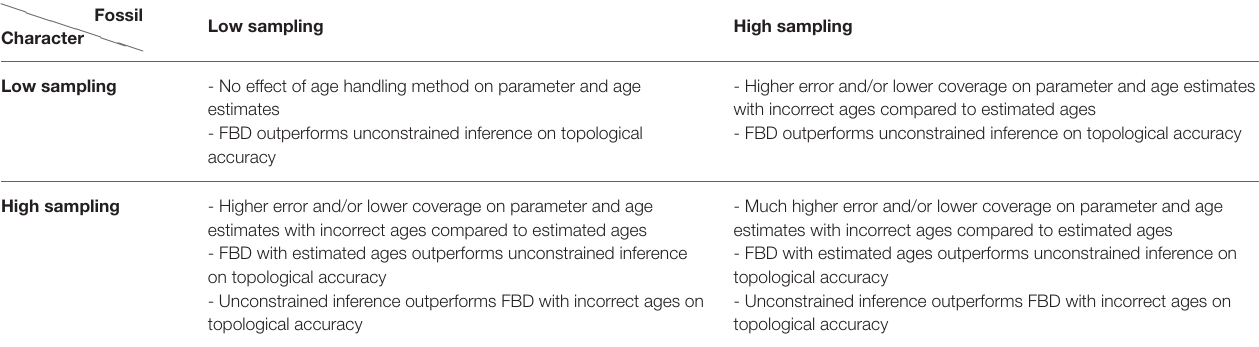
TABLE 2 | Impact of fossil and character sampling on the estimates obtained using the FBD model with different age handling methods vs. unconstrained (i.e., non-clock)